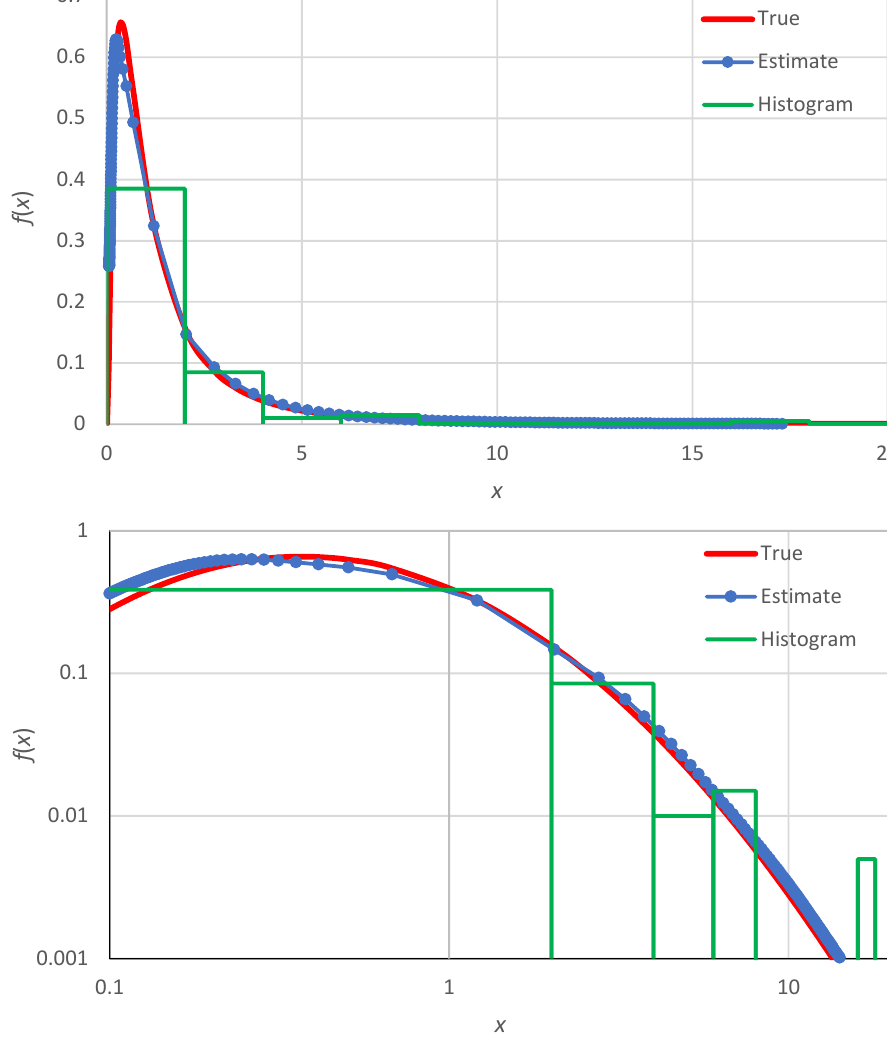
Figure 1. Illustration of the probability density estimate using the proposed method, plotted in Cartesian ( upper ) and logarithmic ( lower ) axes. A data series of n = 100 values was used, generated from a lognormal distribution (see Table 2) with parameters ς = λ = 1. The density of the generating distribution is marked as “true”. The points marked as “estimate” are calculated by the proposed method (Equation (33)) and their abscissae are the midpoints of the intervals (𝐾̂ 𝑝 ′ , 𝐾̂ 𝑝+1 ′ ) and (𝐾̂ 𝑝+1′ 𝐾̂ 𝑝′ , ) . For comparison, the histogram of 10 bins, calculated as in Equation (4) for the range [0, 20] (width w = 2) is also shown.